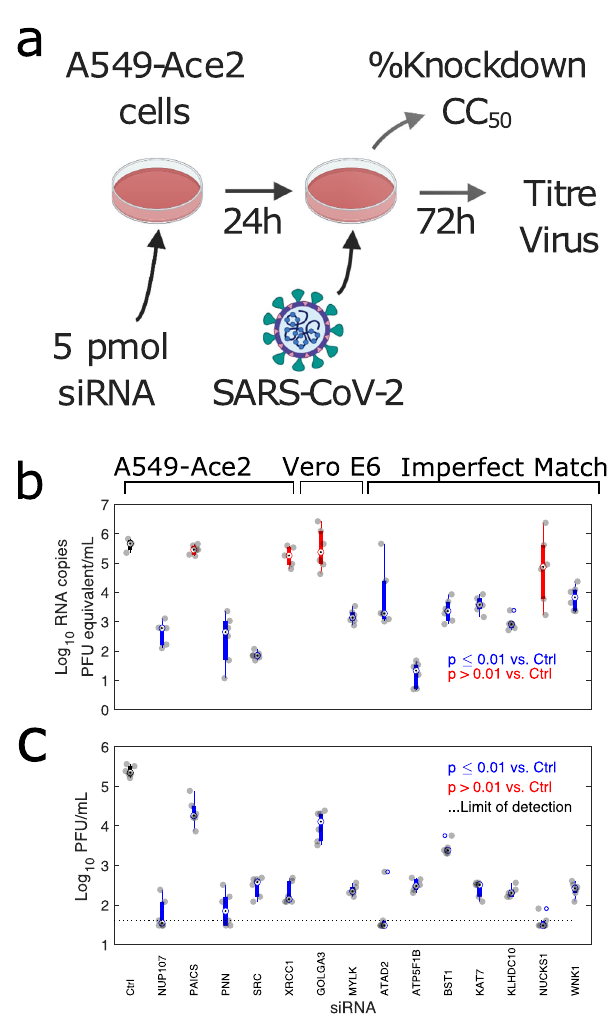
Fig. 5 siRNA depletion of potential MPro and PLP substrates results in signi fi cant reductions to viral RNA copies and titres in A549-Ace2 cells. a Experimental design, b Viral RNA copies ( n = 3 (control), 5 (NUP107, XRCC1), and 6 (all other samples) biologically independent samples), and c titres in supernatant at 72 h post-infection ( n = 6 biologically independent samples), following infection 24 h post-transfection with the indicated siRNA). Boxplot minima/maxima represent the furthest non-outlier datapoints, centre the median, and bounds of box the interquartile range. Outliers are de fi ned as datapoints >1.5 times the interquartile range from the bottom or top of the box. Individual datapoints are shown in grey. Signi fi cance was calculated by one-way ANOVA. Blue bars indicate samples with signi fi cantly reduced viral RNA copies or titres ( p ≤ 0.01). Those not meeting this threshold are shown in red. The control siRNA- treated sample is indicated with a black bar. The limit of detection in the plaque assay was calculated to be 40 PFU/mL (dotted